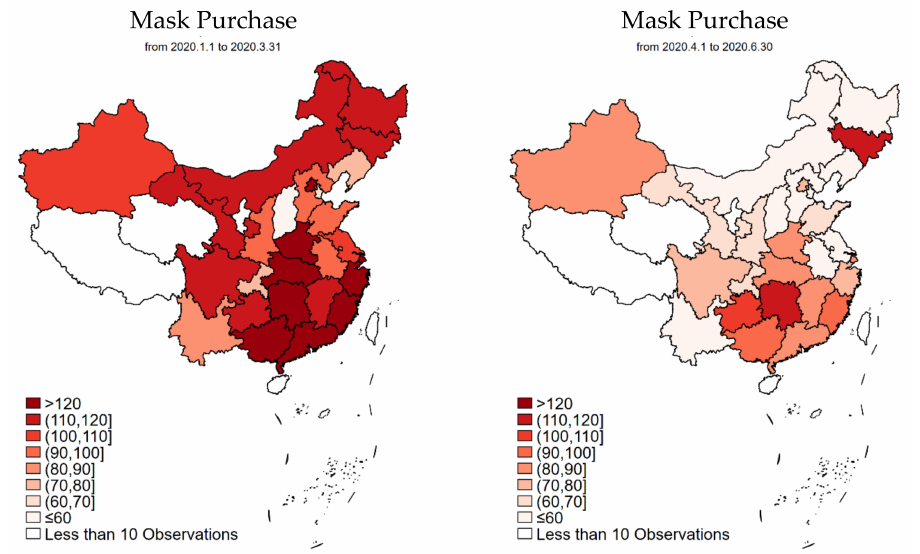
Figure 1. Face mask purchase during Period 1 and Period 2 in China at the provincial level.